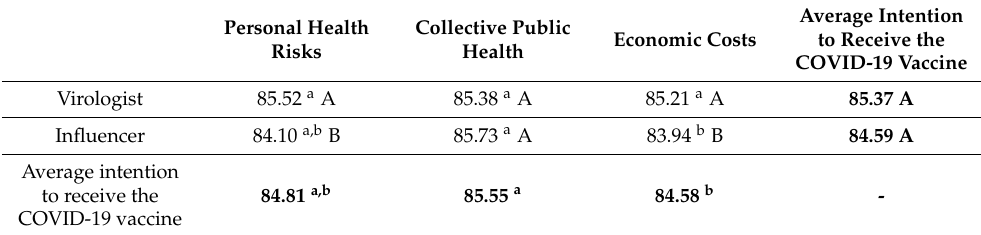
Table 3. Overall intention to receive the COVID-19